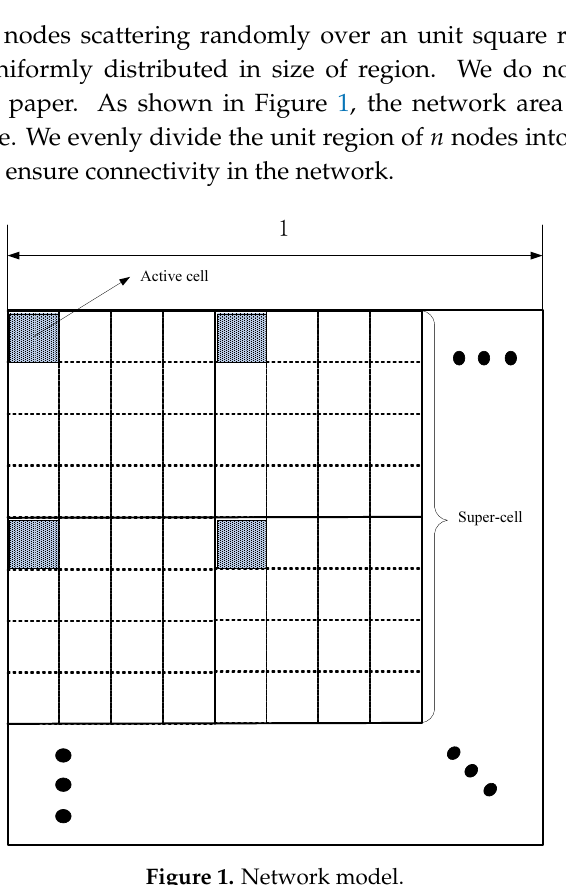
Figure 1. Network